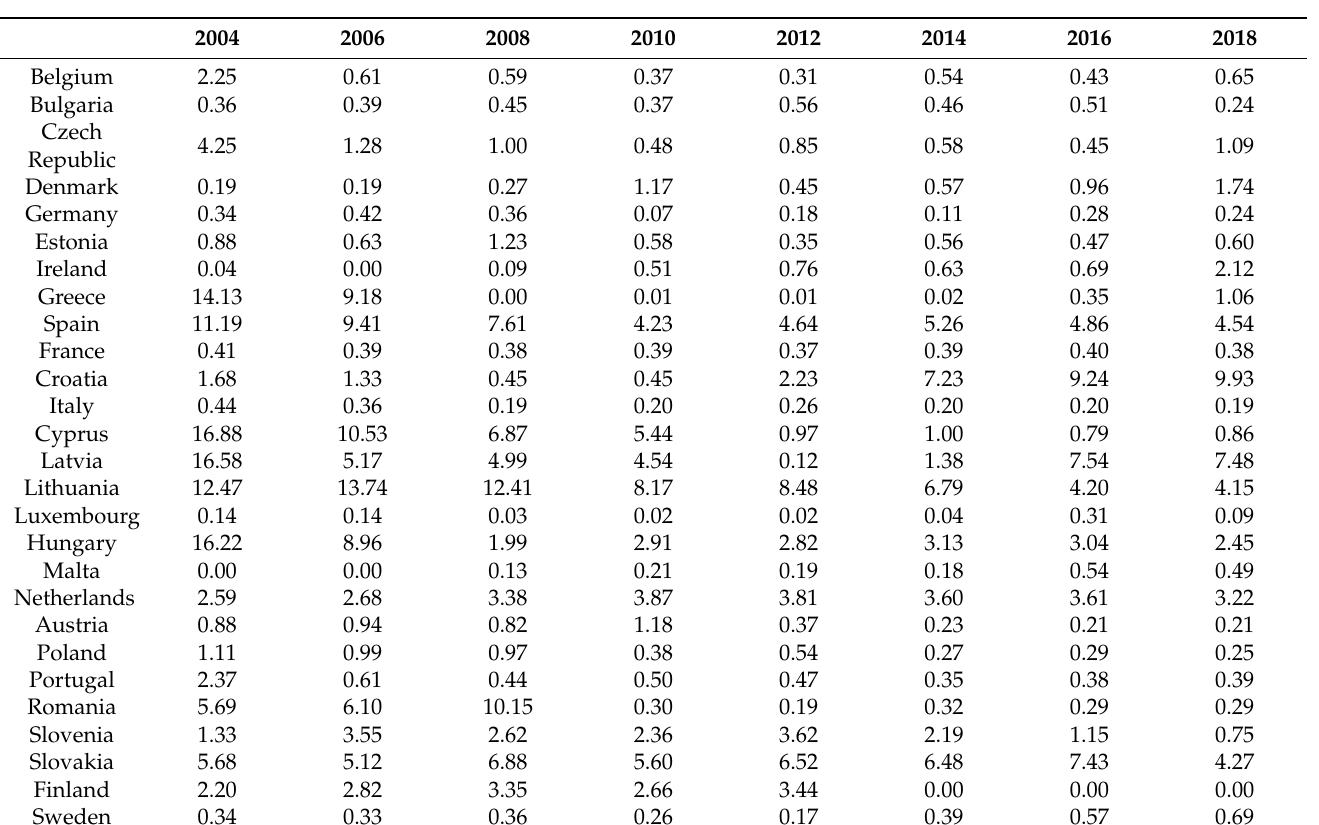
Table 2. Waste generation (in agriculture, as total